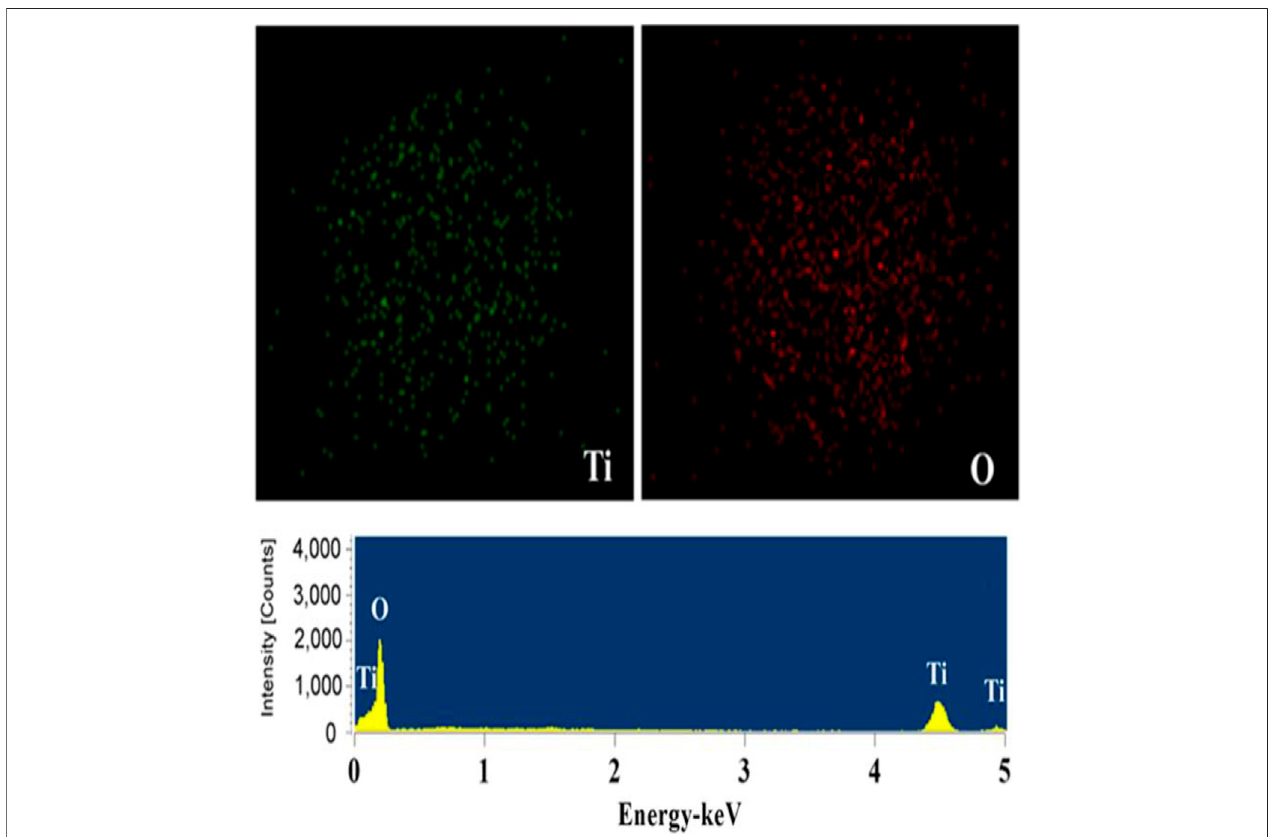
FIGURE 2 | Energy dispersive spectroscopy microanalysis spectrum of porous TiO 2